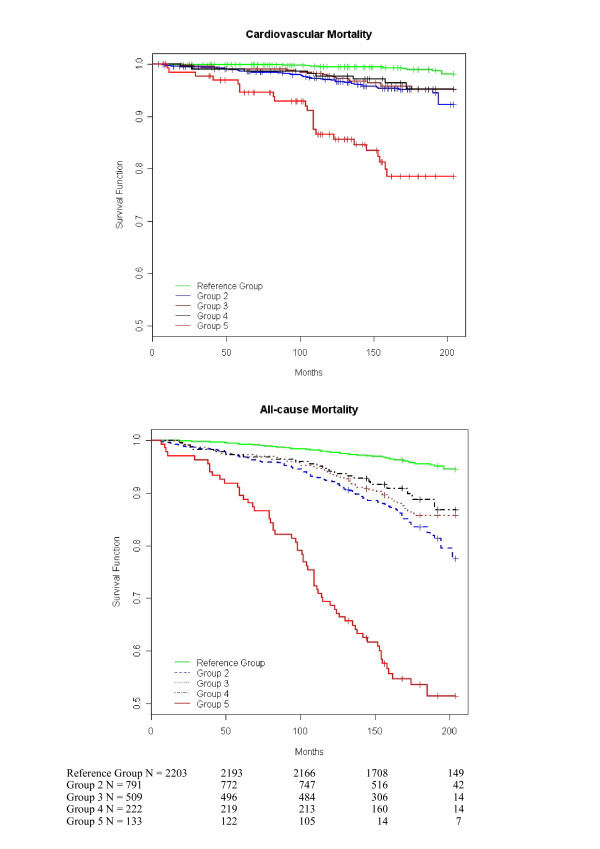
Cardiovascular and all-cause mortality by the blood pressure group. Kaplan-Meier survival curves for cardiovascular and all-cause mortality. Log-rank test for the survival difference between the blood pressure groups: p < 0.0001 for cardiovascular mortality and p < 0.0001 for all-cause mortality. The numbers indicate people remaining in the follow-up at different points in time. All participants were not followed up for 200 months. The reference group consists of patients with normal brachial blood pressure (< 140 mmHg), ankle blood pressure <175 mmHg and exercise blood pressure ≤215 mmHg at the moderate exercise level. Group 2 had elevated ankle blood pressure (≥175 mmHg) but normal exercise blood pressure. Group 3 had elevated ankle and exercise blood pressure. Group 4 had ankle blood pressure < 175 mmHg but elevated exercise blood pressure (discrepancy) and group 5 could not be classified because of poor exercise tolerance.